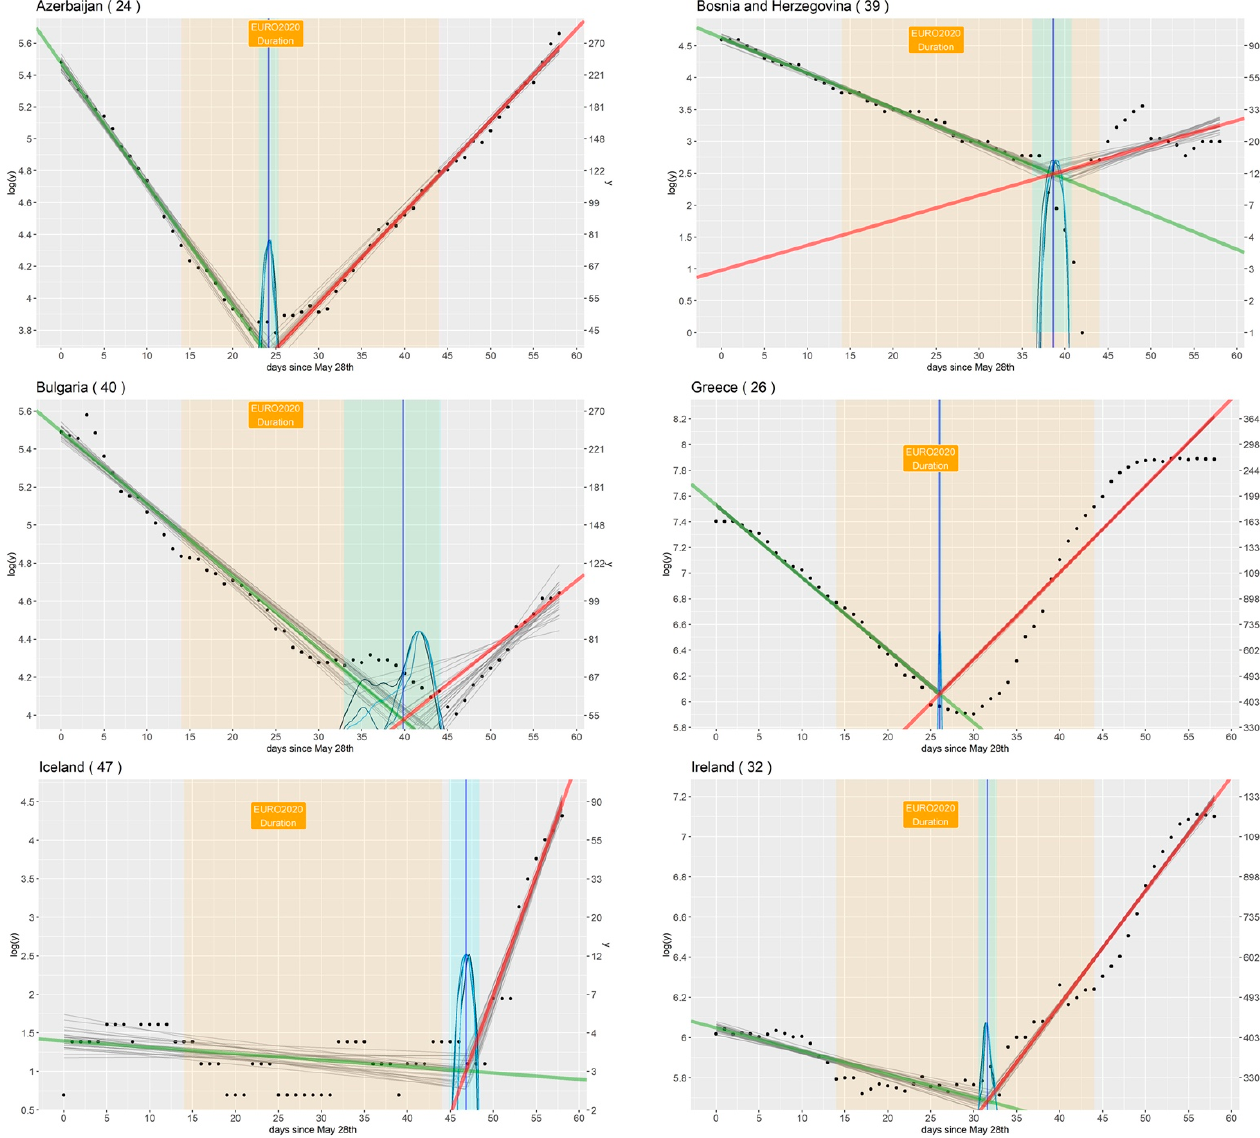
Figure 4. Azerbaijan, Bosnia, Bulgaria, Greece, Iceland, and Ireland not participating countries. Yellow space: duration of the tournament. Red vertical line: first match. Purple vertical line: last match. Green vertical line: last hosted match. Blue vertical line: changepoint. Blue space: CI amplitude for the changepoint. Green segment: case rate trend before the changepoint. Red segment: case rate trend after the changepoint. Blue bell-shaped peaks, grey segments, black dots, and rightmost and leftmost y axis: same as in previous figures.